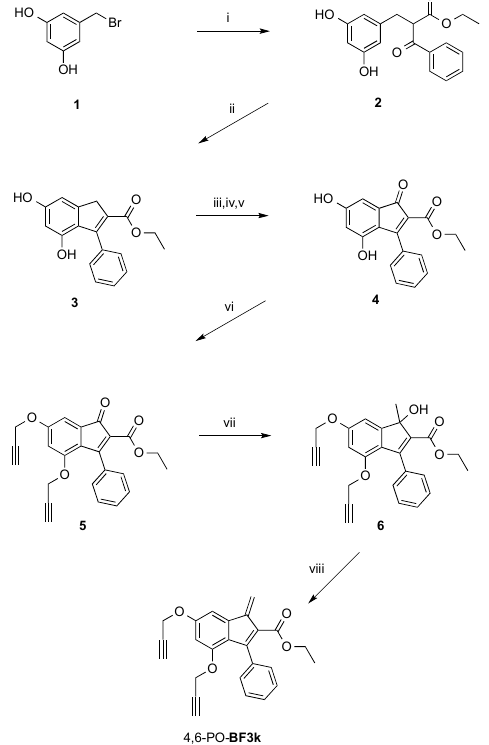
Scheme 2. Synthesis of benzofulvene monomer 4,6-PO- BF3k . Reagents: (i) ethyl benzoylacetate, NaI, K 2 CO 3 , DMF; (ii) PPA; (iii) TBDMSCl, imidazole, CH 2 Cl 2 ; (iv) SeO 2 , dioxane; (v) (C 4 H 9 ) 4 NF, THF; (vi) propargyl bromide, NaI, K 2 CO 3 , CH 3 COCH 3 ; (vii) Al(CH 3 ) 3 , CH 2 Cl 2 ; (viii) PTSA, CHCl 3 .